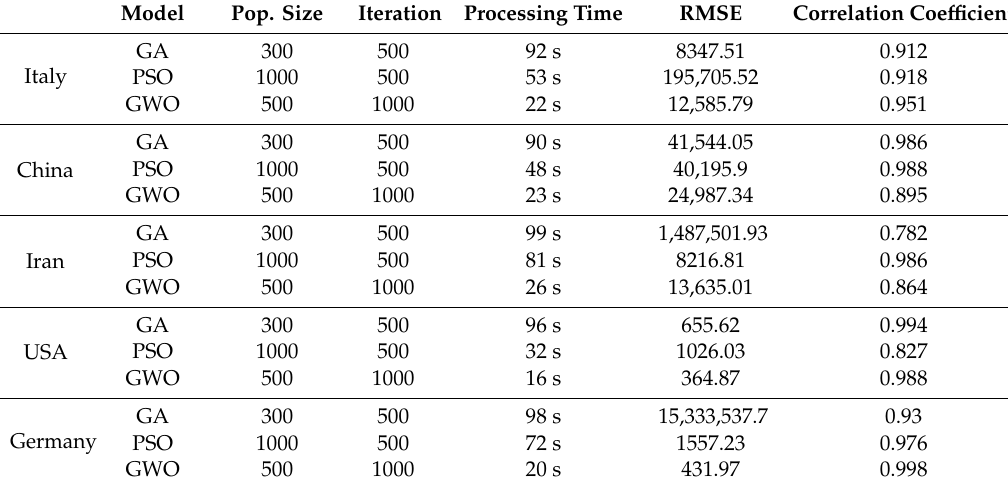
Table 8. Accuracy statistics for the compound